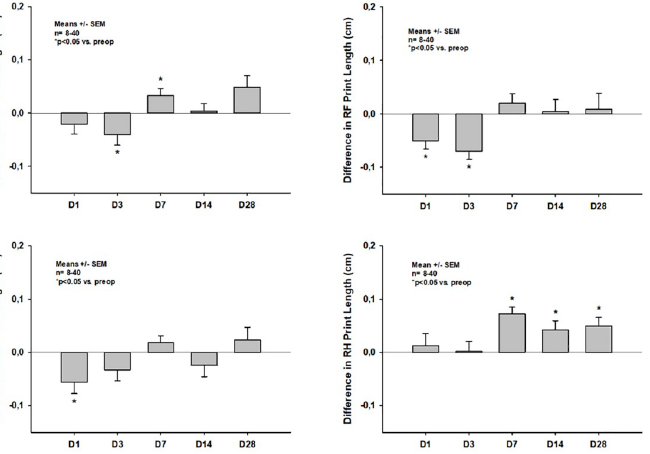
Fig 4. Differences in print length of the four single paws compared to pretrauma status on days one thru 28 after CCI.